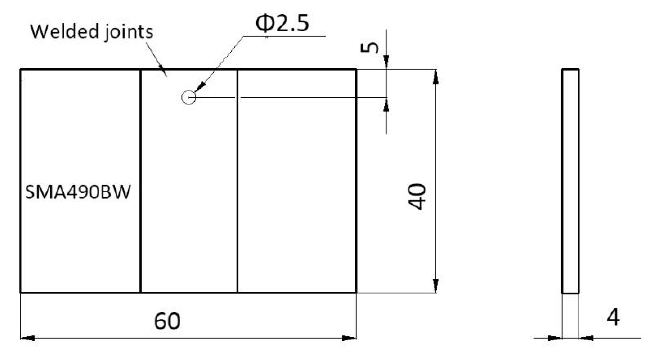
/ dry cyclic corrosion